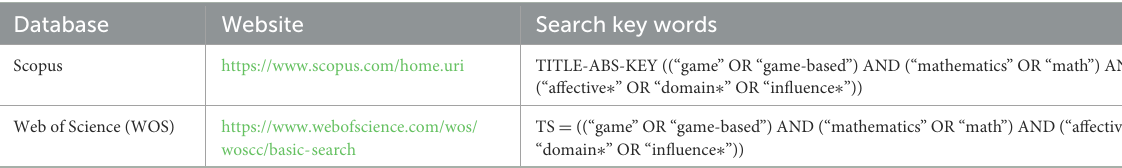
TABLE 2 Article inclusion and exclusion criteria set.